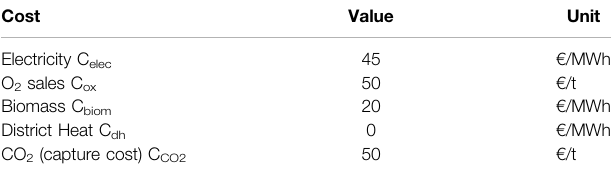
TABLE 2 | Economic parameters used in